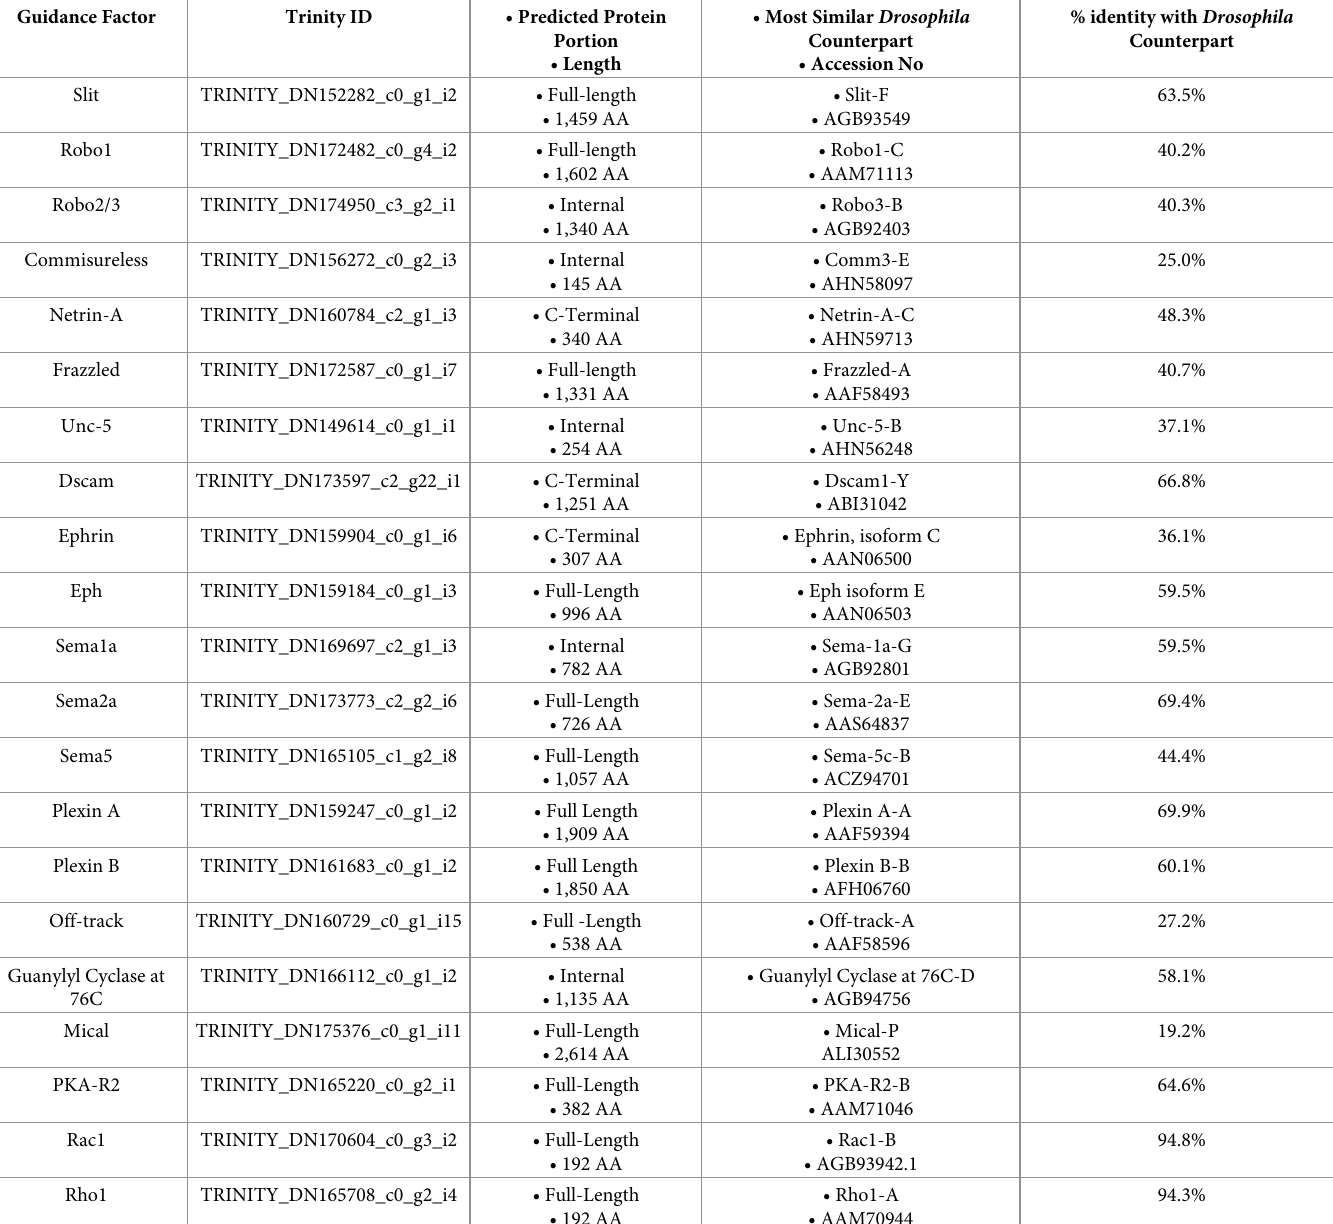
Table 4. Developmental guidance molecules mined from adult prothoracic